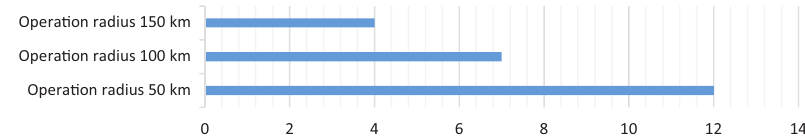
Figure 7. Number of operation area vs operation